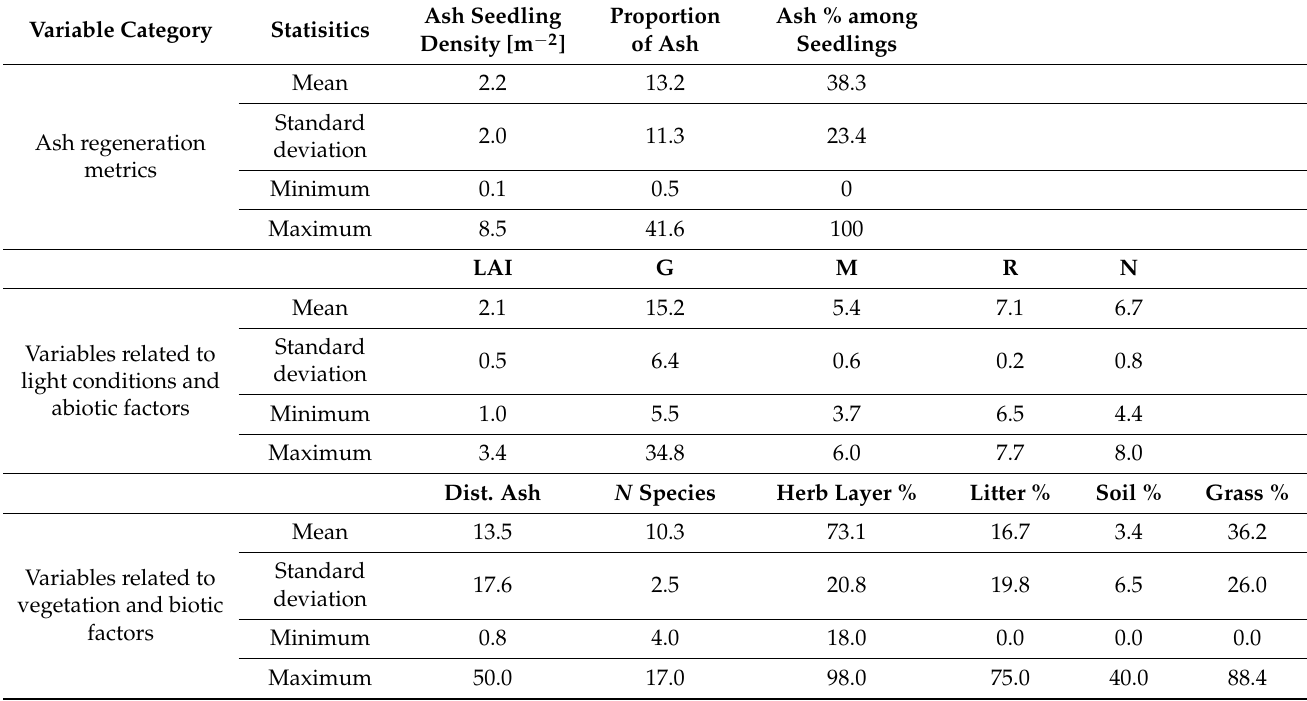
Table 1. Collected variables and their mean, minimum, maximum values including standard deviation. LAI: Leaf Area Index, G: gap fraction (%), M, R, N: Ellenberg indicator values for soil moisture, reaction, and nutrients, N : number, dist. ash (m): distance to the nearest adult ash